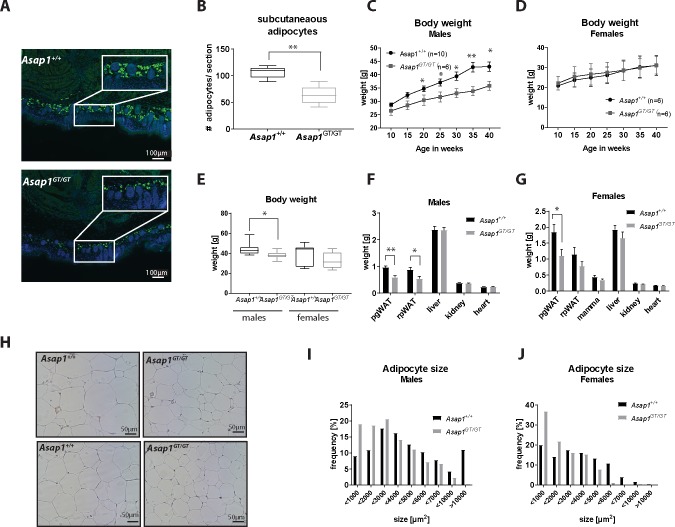
Loss of ASAP1 results in decreased numbers of neonatal subcutaneous adipocytes and reduced body weight.(A) Transverse sections at the level of the scapulae of neonatal WT and Asap1GT/GT embryos were stained for perilipin A (green fluorescence) and DAPI (blue), which demonstrated a reduced number of perilipin A-positive subcutaneous adipocytes in Asap1GT/GT neonates (P0). (B) Quantification of the number of subcutaneous adipocytes. The number of perilipin A-positive cells per picture of three adjacent scapulae sections was counted and averaged. The box-whisker plots show the mean values and the 25th and 75th percentiles for Asap1+/+ (n = 5) and Asap1GT/GT embryos (n = 6) ± min to max. (C) Body weight (BW) of male WT and Asap1GT/GT mice at the age of 10 to 40 weeks. Data represents mean ± SEM (Asap1+/+, n = 10 and Asap1GT/GT, n = 6). (D) Body weight (BW) of female WT and Asap1GT/GT mice at the age of 10 to 40 weeks. Data represents mean ± SD (Asap1+/+, n = 6 and Asap1GT/GT, n = 6). (E) Body weight of male and female WT and Asap1GT/GT mice at the age of 18 months. The box-whisker plots show the mean values and the 25th and 75th percentiles for Asap1+/+ (male n = 11, female n = 9) and Asap1GT/GT (male n = 8, female n = 8) ± min to max. (F and G) Weight of perigonadal WAT (pgWAT), retroperitoneal WAT (rpWAT), liver, kidney and heart of WT and Asap1GT/GT mice at the age of 18 months. (H) Representative pictures of male (upper panels) and female (lower panels) pgWAT of aged WT and Asap1GT/GT mice (age 18 months). (I) Distribution of adipocyte size in pgWAT from WT and Asap1GT/GT male mice (Asap1+/+ n = 6, Asap1GT/GT n = 5). (J) Distribution of adipocyte size in pgWAT from WT and Asap1GT/GT female mice (Asap1+/+ n = 4, Asap1GT/GT n = 4). Significance was calculated using the Student’s t-test.*, p < 0.05, ** p < 0.005.